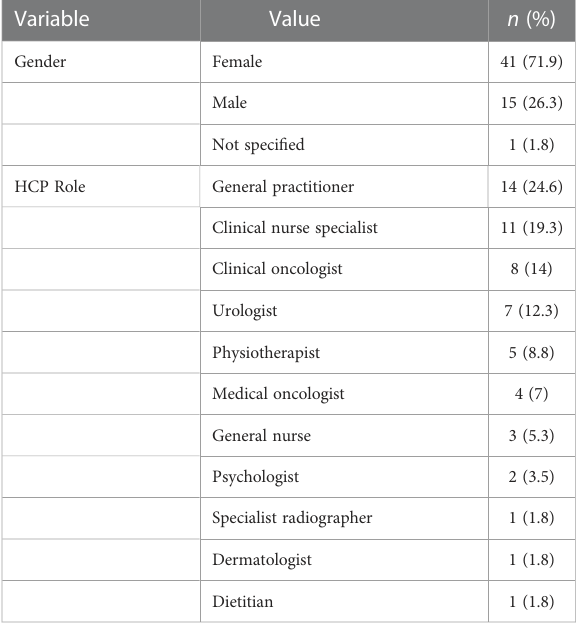
TABLE 2 Preparation phase participants ’